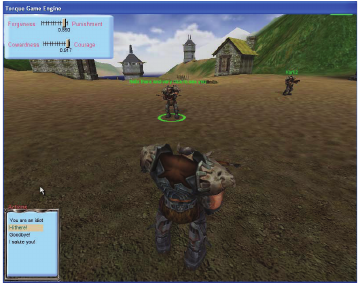
Figure 1: The Moody NPCs